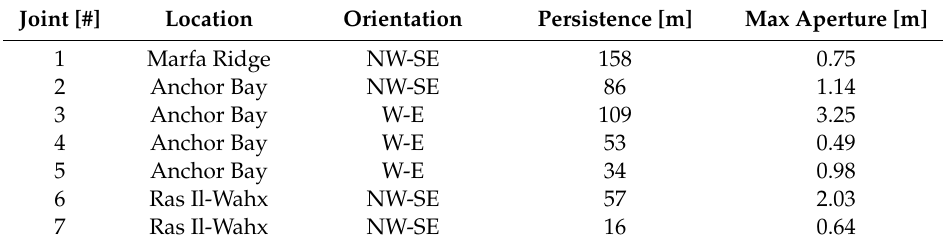
Table 7. Main joints recognized by 3D models analysis.